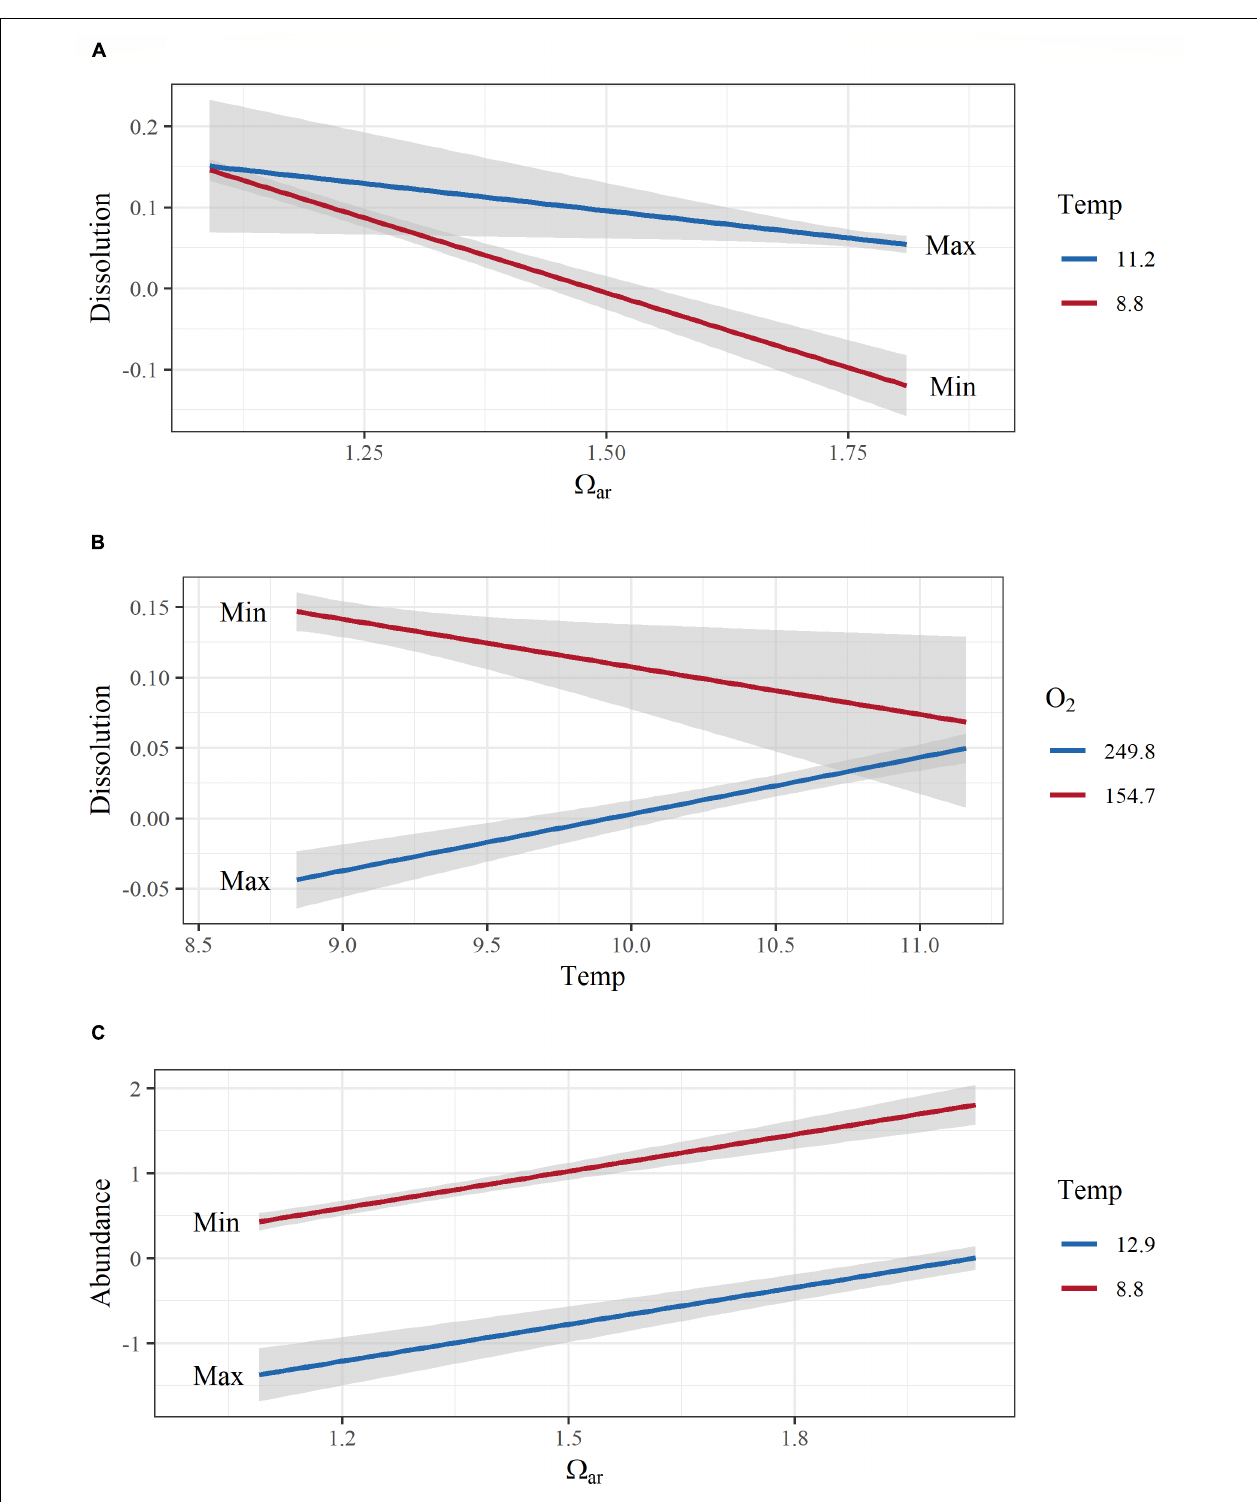
FIGURE 7 | Model interactions and additive effects of co-occurring environmental variables with biomineralization (shell dissolution) and population (abundance) responses. Interactive effects between aragonite saturation state ( (cid:127) ar ) and temperature on biomineralization (shell dissolution) are shown in (A) , temperature and O 2 on dissolution in (B) , and the additive effect of temperature and (cid:127) ar on abundance in (C) . All y -axes are transformed to conform to model output. Covarying environmental variables were held constant at the minimum and maximum values in the observed data. Color range depicts the max and min values of the observed